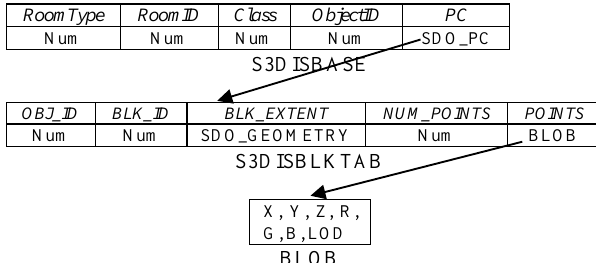
Figure 9. Schema of the SDO_PC solution. It includes the base table S3DISBASE, the block table S3DISBLKTAB, and the BLOBs for real storage of points.